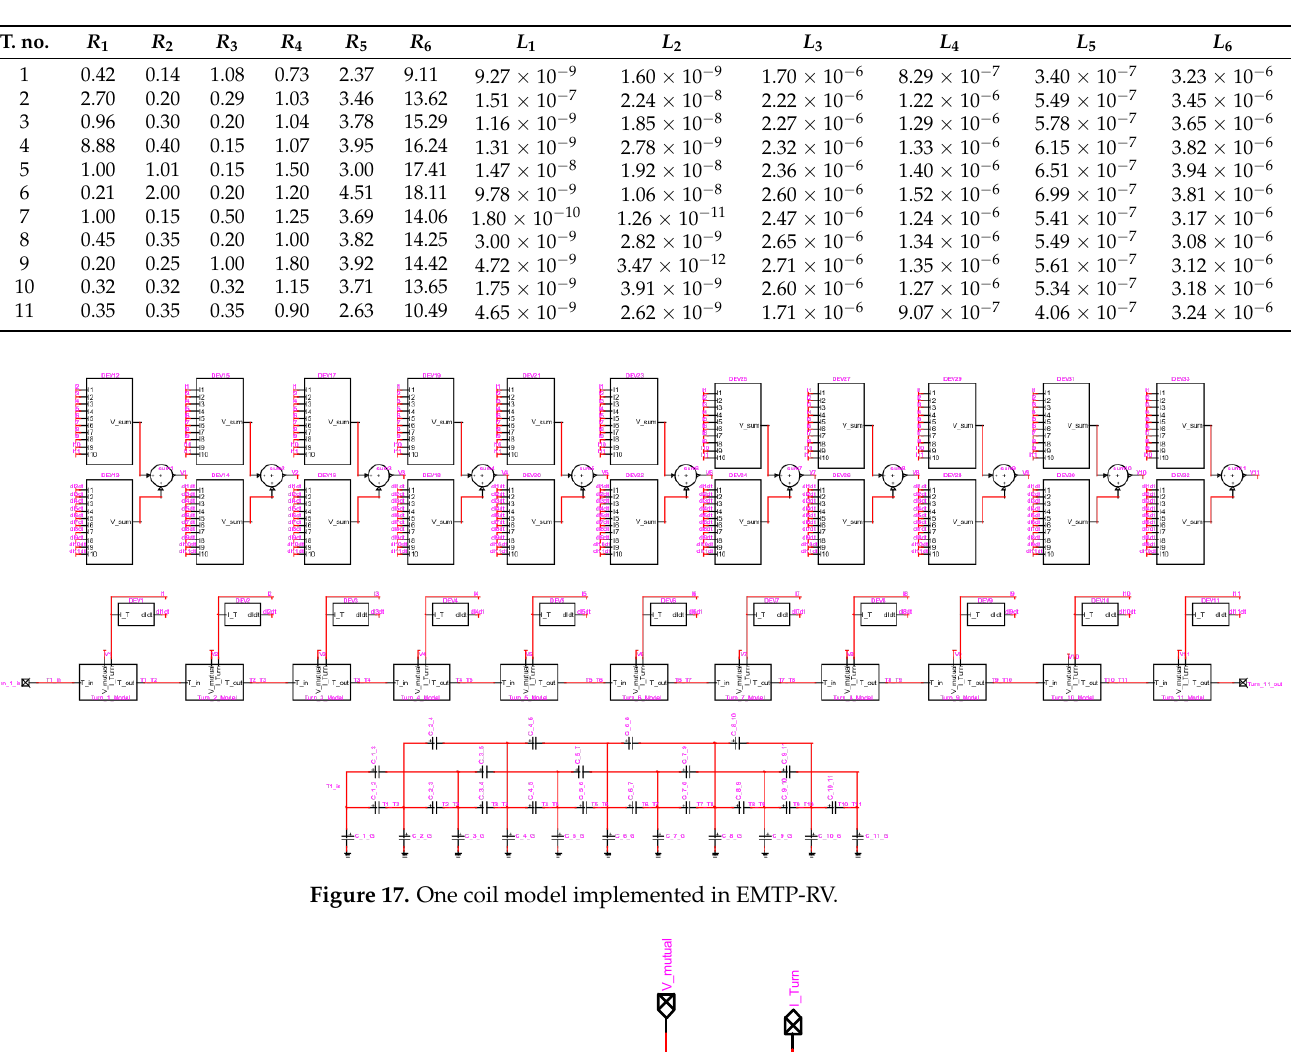
Table 6. Elements of ladder circuits with six layers (R ( Ω ), L (H)) to represent the frequency-dependent self-resistances and -inductances of different turns in the MCTL model.